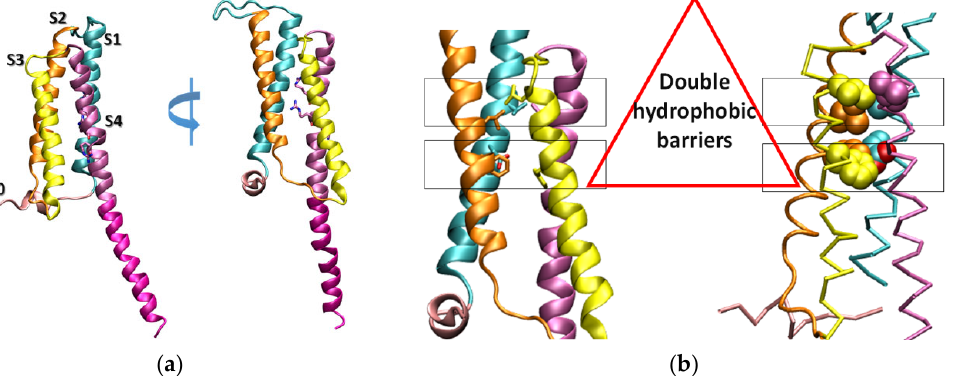
Figure 1. ( a ) The crystal structure of mHv1cc. The ribbon model of the overall crystal structure of mHv1cc, viewed from two different angles rotated 90 ◦ along the membrane bilayers. The four transmembrane segments, or helices S1 (cyan), S2 (orange), S3 (yellow), and S4 (purple), connected to the cytoplasmic coiled-coil region (magenta) are shown. The N-terminal cytoplasmic helix (S0) is colored in pink. Three arginine residues, Arg201, Arg204, and Arg207, in S4 are shown as sticks. ( b ) The double hydrophobic layers of the mHv1cc. The residues in two layers are shown by sticks (left) and spheres in the 90 ◦ rotated one (right). The upper layer close to the extracellular side consists of four highly conserved hydrophobic residues (Val112 (S1), Leu143 (S2), Leu185 (S3), and Leu197 (S4)). The lower layer consists of two hydrophobic residues—Phe146 (S2) and Phe178 (S3)—and one hydrophilic residue—Asp108 (S1, oxygen atom colored in